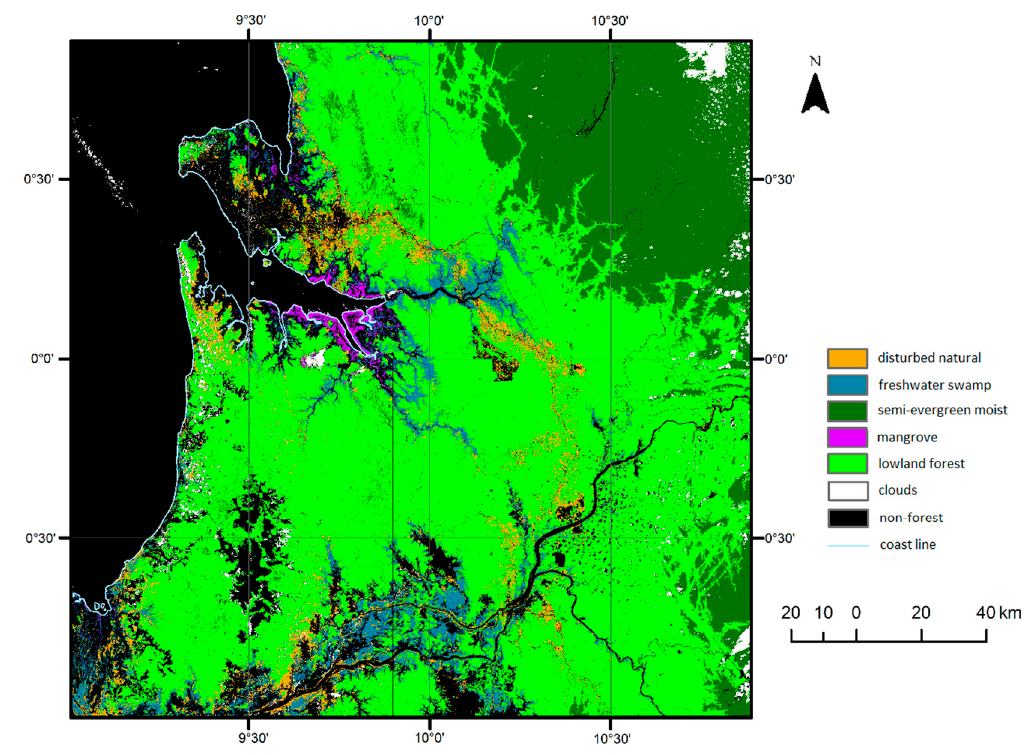
Figure 7. Forest type map obtained as a result of RF classification based on the combination of 10 m, 20 m Sentinel-2 bands and DEM.